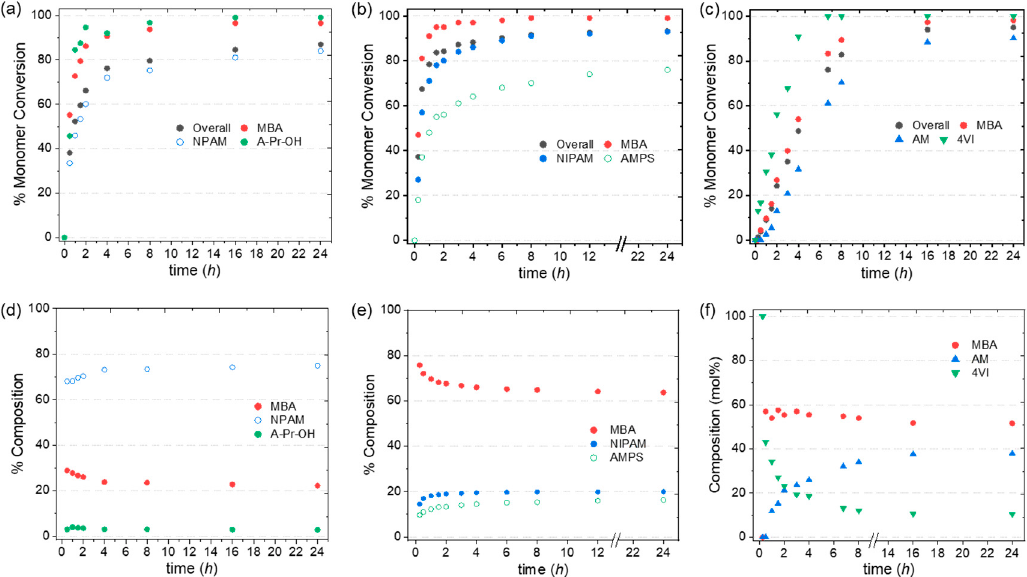
Figure 5. ( a )–( c ) Kinetic profiles for nanogels N29 , N36 , and N44 , respectively; ( d )–( f ) variation of polymer composition over time derived from 5(a)–(c). [ N29 : 2.5 mol% A–Pr–OH, 77.5 mol% NPAM, and 20 mol% MBA; N36 : 20 mol% AMPS, 20 mol% NIPAM, and 60 mol% MBA; N44 : 10 mol% 4VI, 40 mol% AM, and 50 mol% MBA].